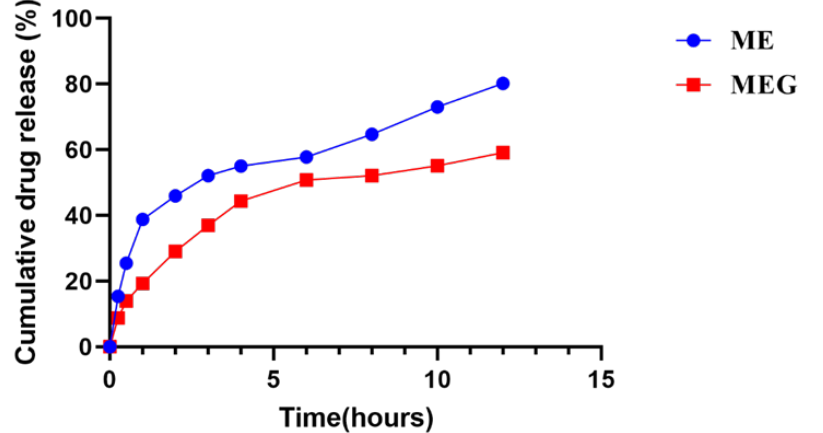
Figure 5. Comparison of (%) cumulative drug release from microemulsion and microemulgel after 12 h. ME is a code representing microemulsion and MEG is a code used for microemulgel in release studies.